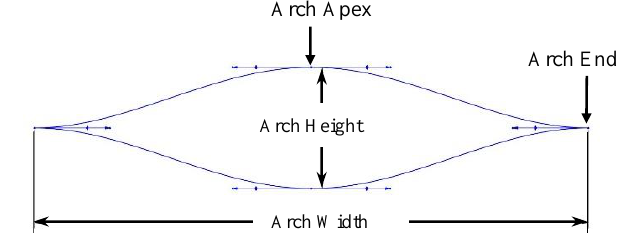
Figure 2. A single cylindrical arch design and the arch aspect